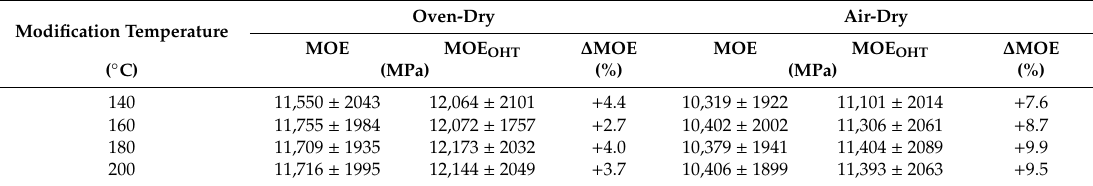
Table 2. Mean value of spruce wood modulus of elasticity (MOE), before to and after modifications, at di ff erent temperatures and moisture content levels; ±